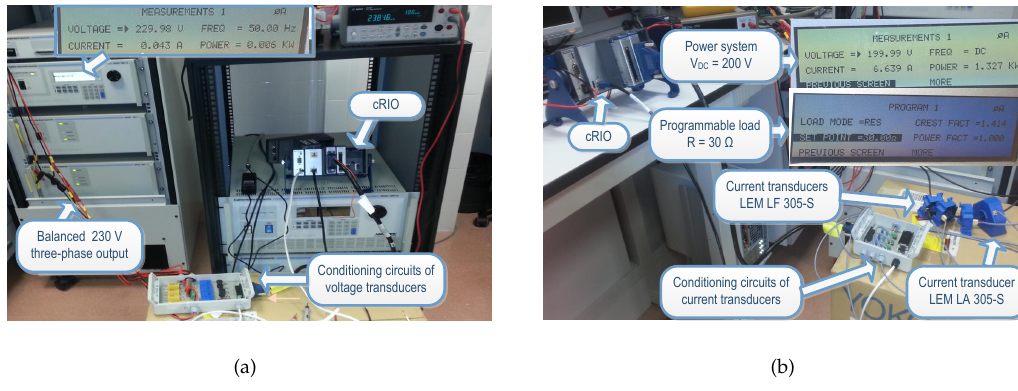
Figure 6. Calibration of the conditioning circuits developed joint to the CompactRIO programmable controller (cRIO): ( a ) Test for voltage transducers; ( b ) Test for current transducers.